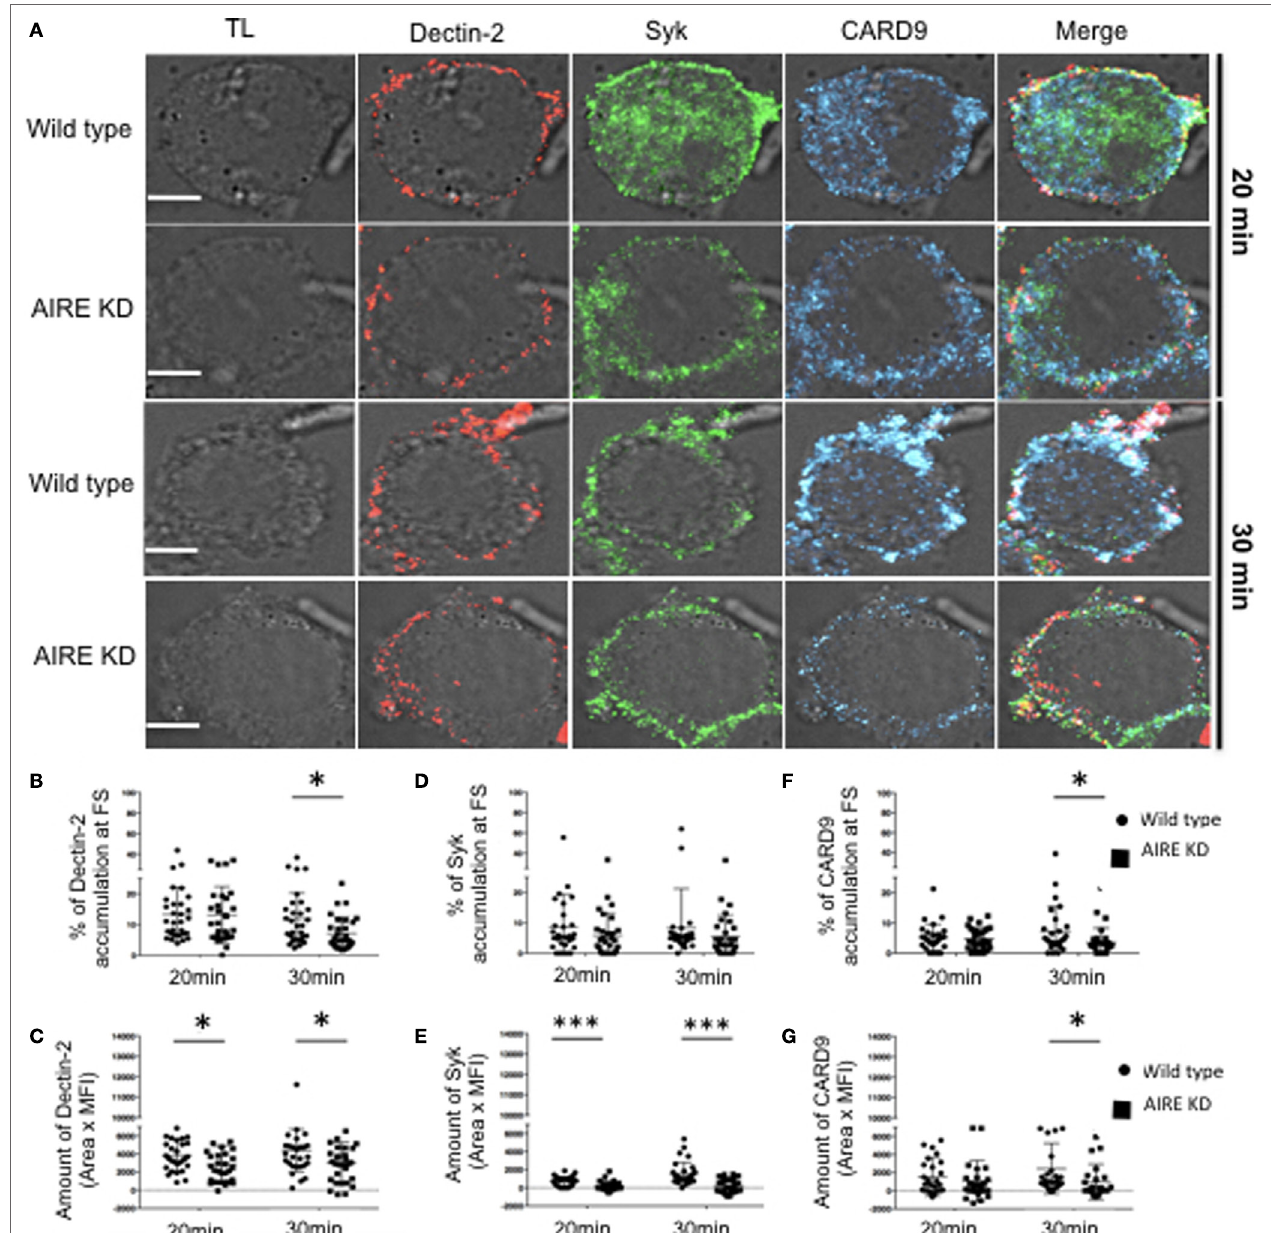
FigUre 4 | Influence of autoimmune regulator (AIRE) on fungal synapse (FS) formation. (a) Representative confocal micrographs of wild-type and AIRE-knockdown macrophage-like THP-1 cells stimulated with C. albicans hyphae for 20 or 30 min to observe the recruitment of Dectin-2 (red), Syk (green), and CARD9 (blue) to FS. (B–e) Each dot represents a cell used for the measurement indicated. The horizontal bars denote the mean. * p < 0.05 as determined by the t -test. (B,D,F) Percentages of total Dectin-2 (B) , Syk (D) and (F) CARD9 at the FS compared with those in the whole cell. (c,e,g) Amount of Dectin-2 (c) , Syk (e), and CARD9 (g) at the FS (conjugated–unconjugated cells). Representative confocal micrographs of 30 cells counted in 3 independent experiments. Scale bar = 5